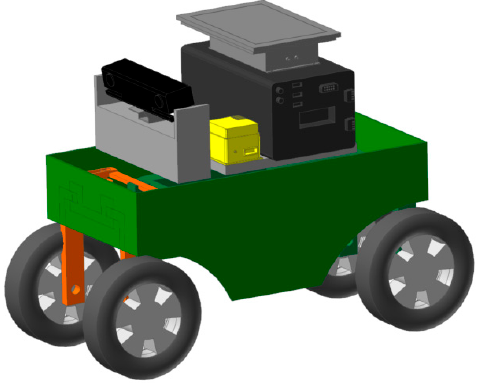
Figure 14. Three dimensional drawing of robot chassis simulation.